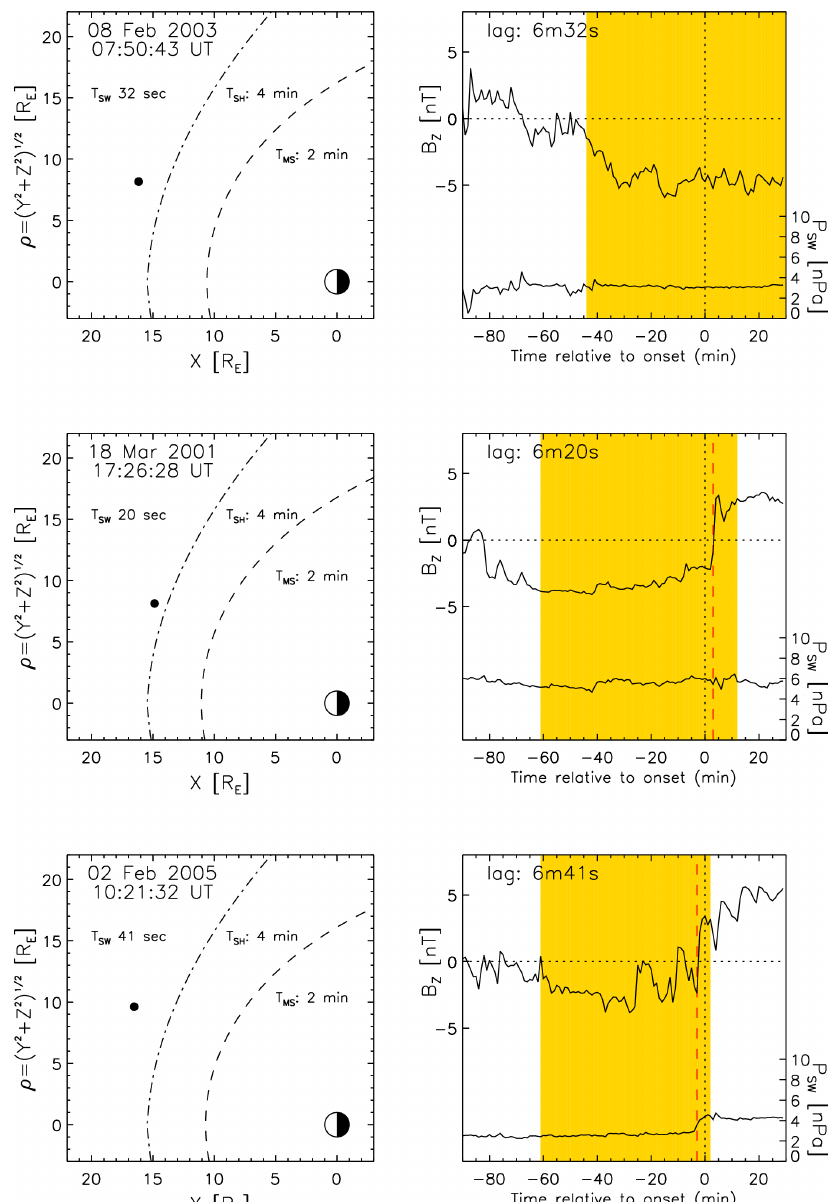
Fig. 2. Examples of IMF and solar wind conditions during 3 of the 260 substorm onsets investigated in this study. For each substorm, the left hand panel indicates the location of the Cluster 1 spacecraft relative to a model bow shock and magnetopause (as in Fig. 1). The right hand panels indicate the B Z component of the IMF and the solar wind dynamic pressure ( P SW ) as a function of time relative to substorm onset (with the time of onset shown by a vertical dotted line). Intervals during which the IMF conditions satisfy triggering criterion 1 of Lyons et al. (1997) are shaded yellow while instances where all 4 triggering criteria are satisfied are indicated by dashed red vertical lines. In the uppermost example, the criteria are not satisfied at any time and no dashed red line is